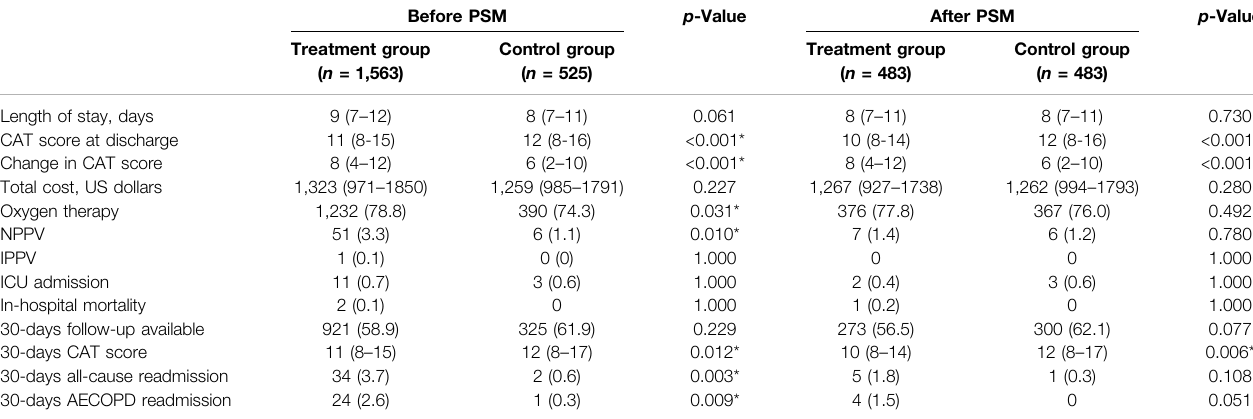
TABLE 3 | Outcomes of hospitalized AECOPD patients treated with or without